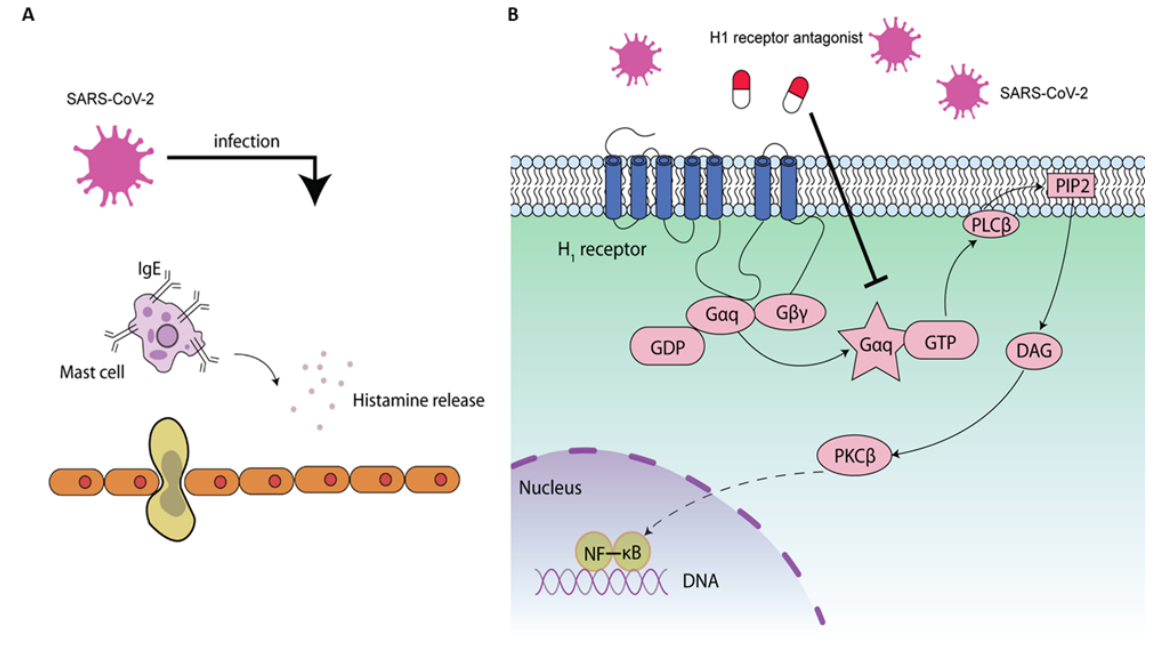
Figure 2. The potential antiviral mechanisms of H1 receptor antagonists on SARS-CoV-2. SARS-CoV-2 infection leads to histamine release ( A ) and activates the NF-κB signaling ( B ), leading to enhancement of inflammatory response to facilitate its replication [81]. Histamine-mediated NF-κB signaling has been associated with the upstream phospholipase C (PLC) and protein kinase C (PKC) activation [82]. The activation of NF-κB by histamine can be blocked by H1 receptor antago- nists [83]. H1 receptor antagonists may inhibit the NF-κB signaling through H1 receptor-dependent or -independent mech- anisms [84].